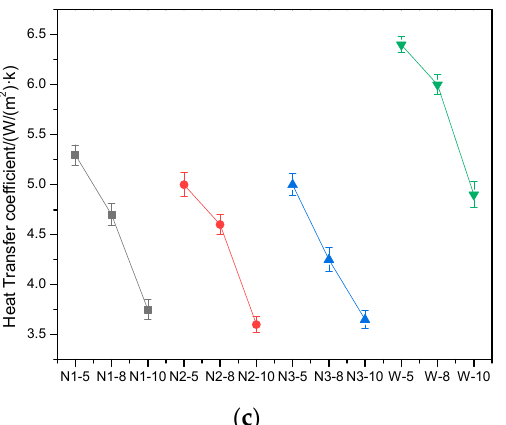
Figure 4. Results of ( a ) CLO values, ( b ) heat preservation rates, and ( c ) heat transfer coefficients of waddings.